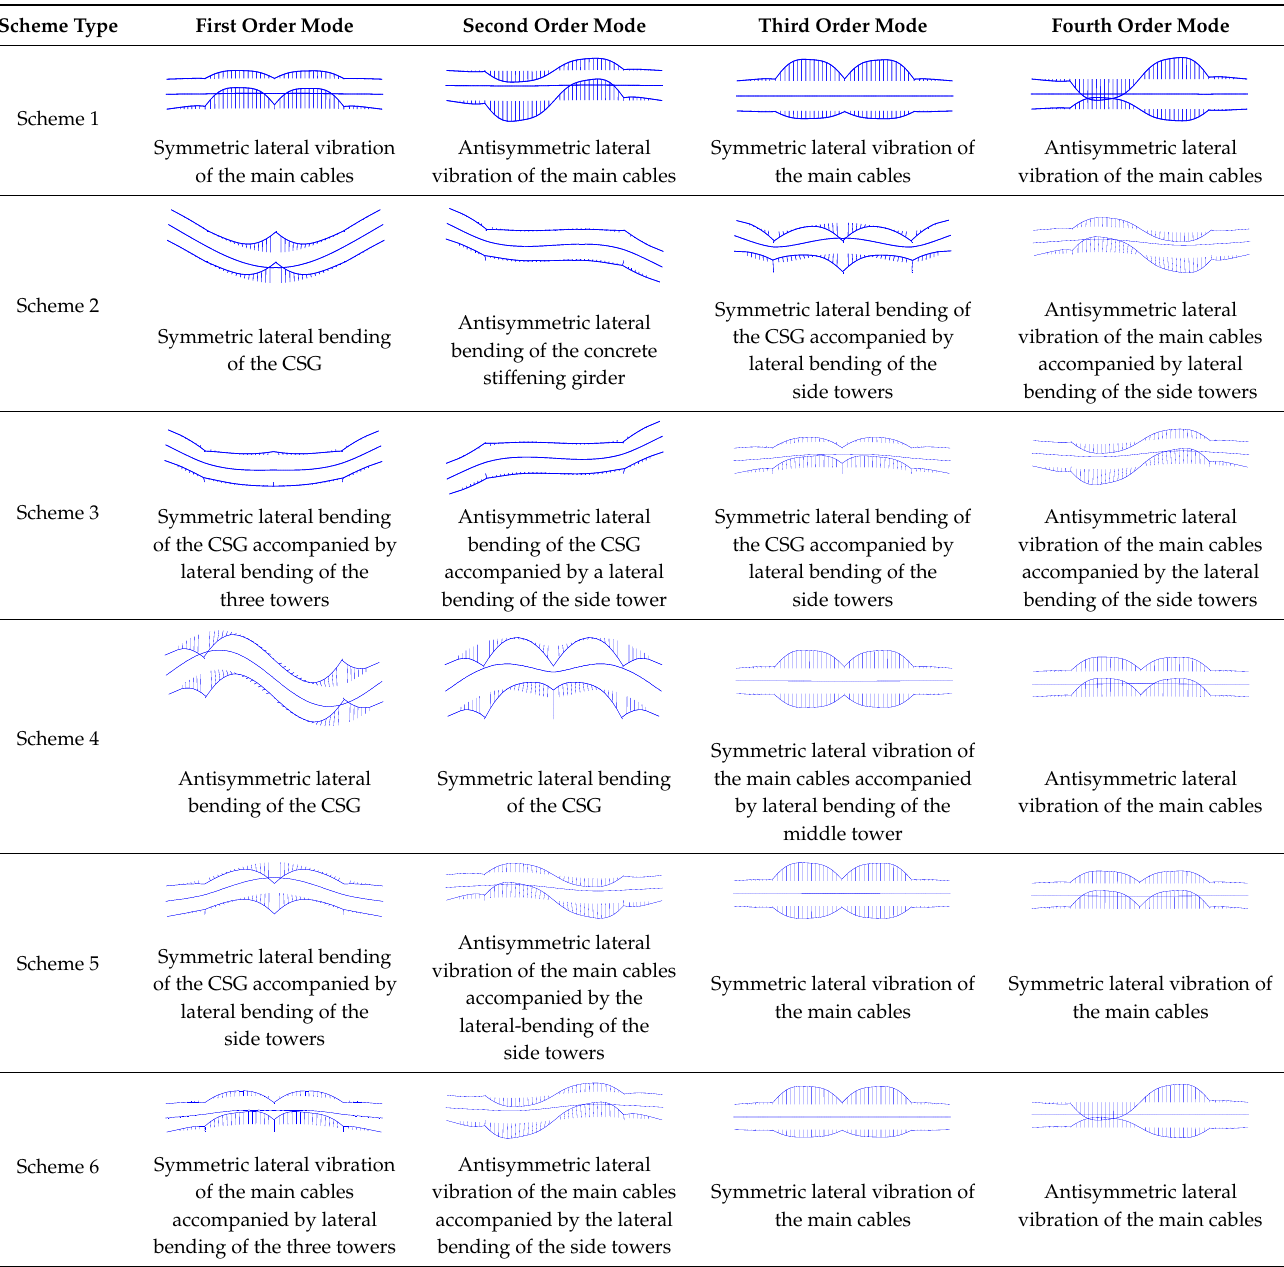
Table 3. The first four lateral vibration modes of the bridge with different layout schemes.